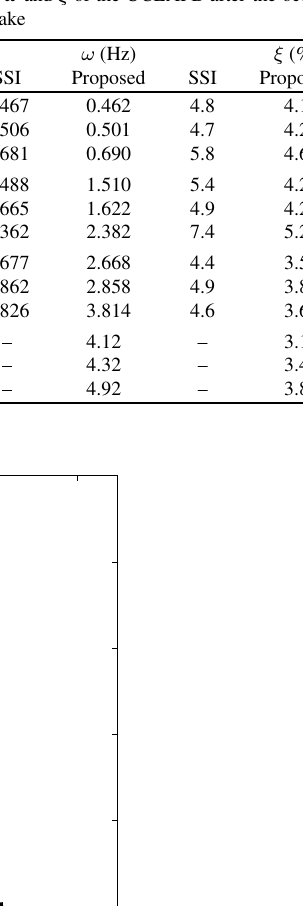
Table 4 Damaged state: Identified ω and ξ of the UCLAFB after the occur-